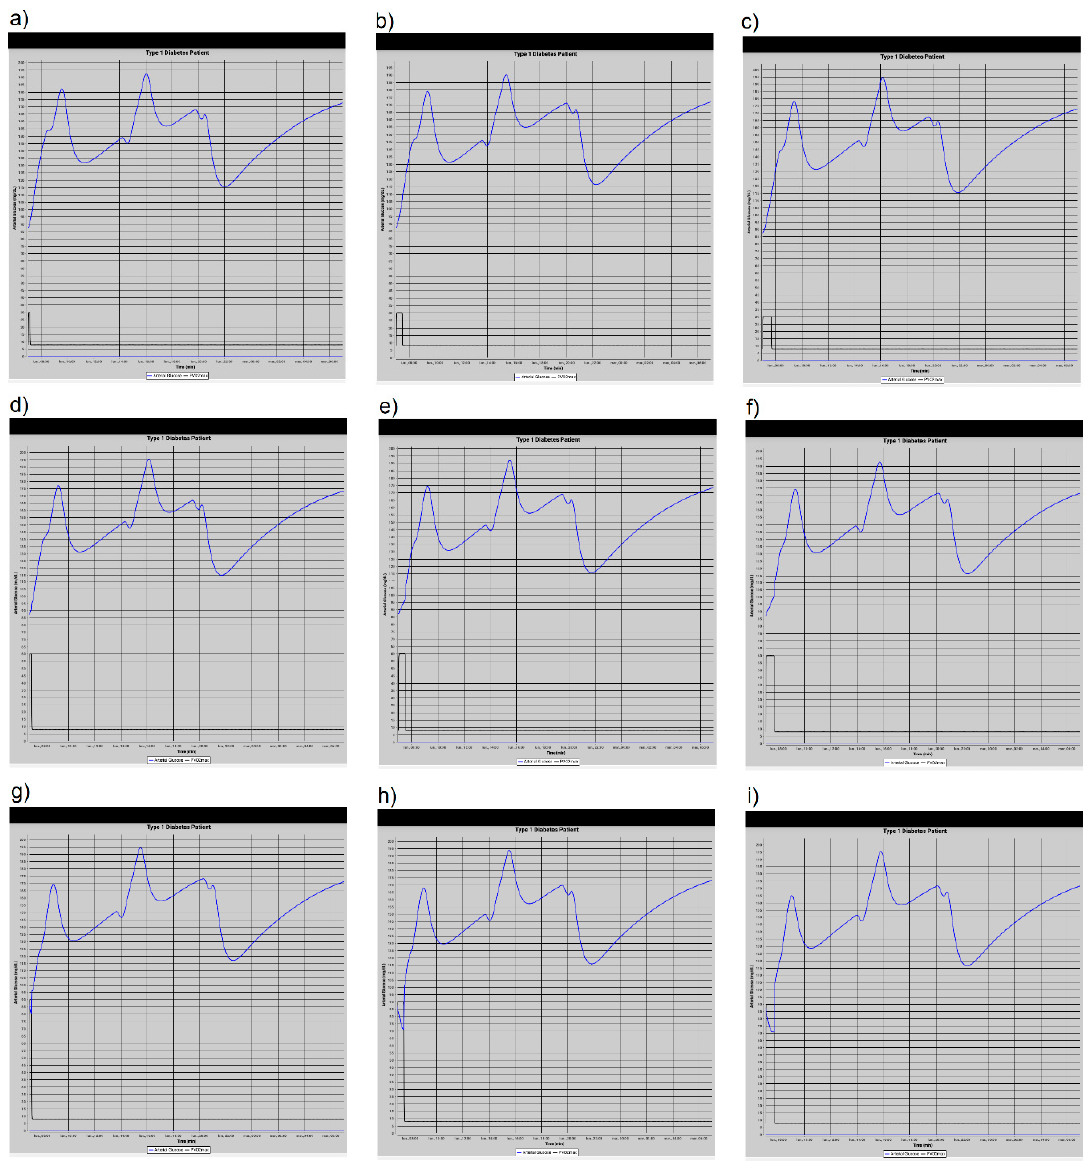
Figure 6. Comparison of blood glucose plots generated by AEDMA application for several exercise intensities using experiment 1 settings. ( a ) Light exercise—10 min. ( b ) Light exercise—30 min. ( c ) Light exercise—90 min. ( d ) Moderate exercise—10 min. ( e ) Moderate exercise—30 min. ( f ) Moderate exercise—90 min. ( g ) Heavy exercise—10 min. ( h ) Heavy exercise—30 min. ( i ) Heavy exercise—90 min.